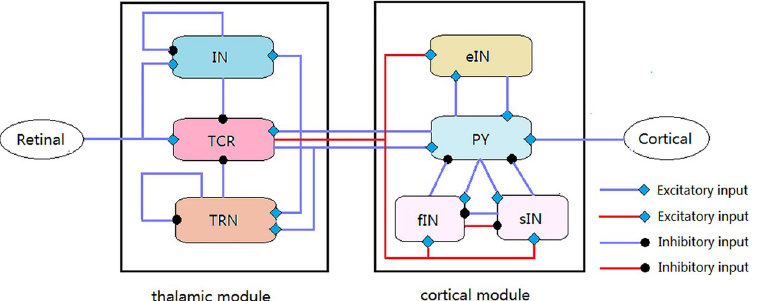
Fig 1. Schematic diagram of the modified TCT model presented in this work. The synaptic structures of the thalamic and the cortical module are based on Ref. [40] and Refs. [33, 41], respectively. Blue lines with arrow heads and round heads denote the excitatory and inhibitory synaptic projections existing in the original TCT model, respectively. Red lines with arrow heads and round heads indicate the excitatory and inhibitory synaptic projections newly introduced in the modified TCT model,